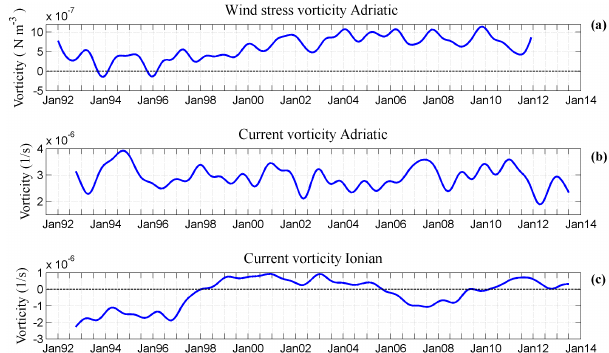
Figure 2. Time series of the spatially averaged, low-pass filtered (13 months) wind-stress vorticity (a) and current vorticity (b) in the Adriatic Sea, computed over the domain denoted in Fig. 1. Time series of the low-pass filtered current vorticity in the Ionian Sea (c) spatially averaged over the domain presented in Fig.